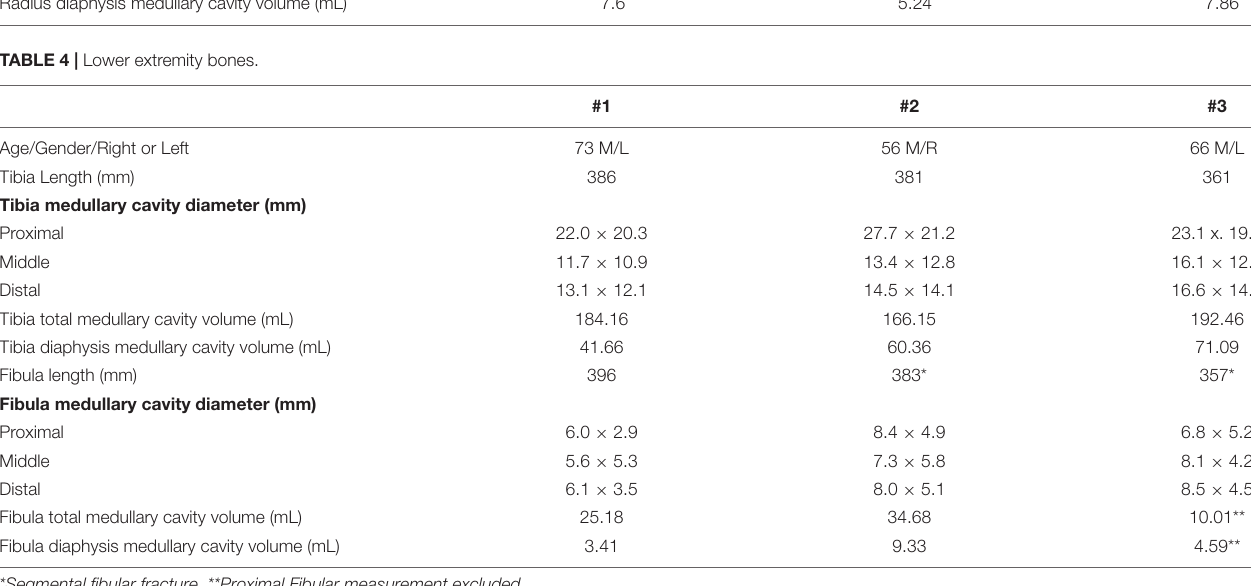
*Segmental fibular fracture. **Proximal Fibular measurement excluded. TABLE 5 | Percent of medullary bone removed for virtual